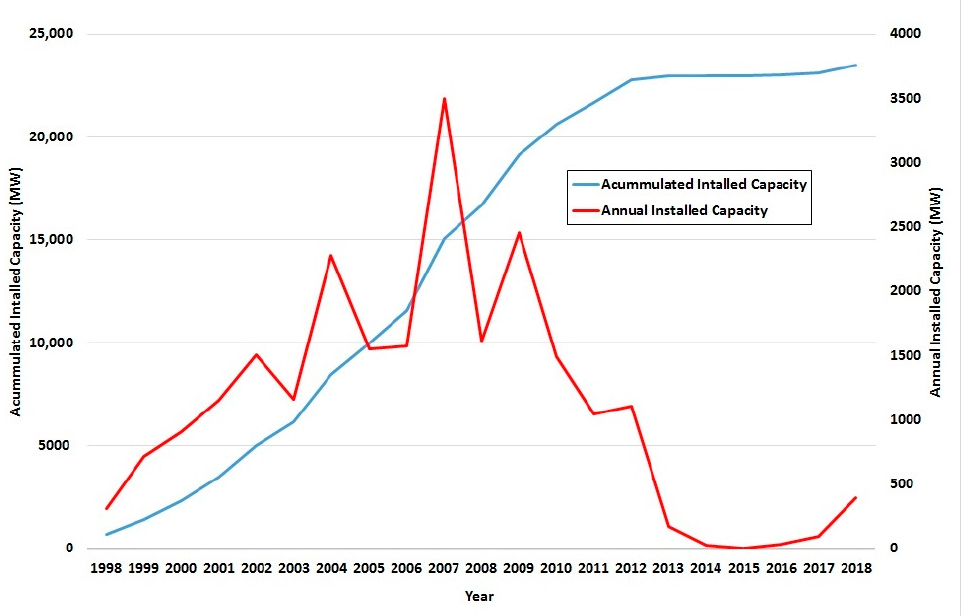
Figure 2. Trend in annual and accumulated installed wind power capacity in Spain. Source: drawn up by authors with data from AEE [6].